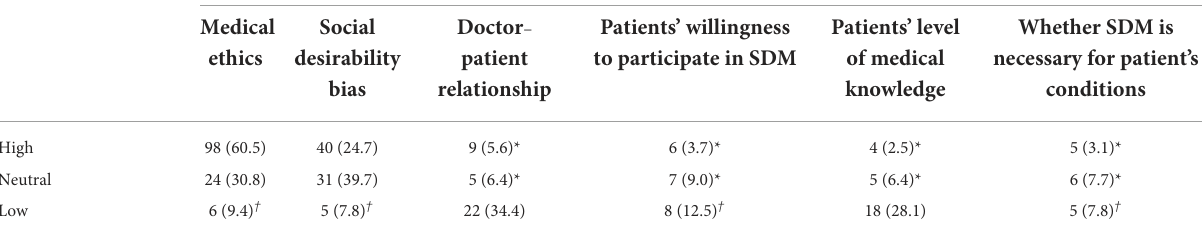
TABLE 6 Reasons for different preferences for shared decision-making (SDM) [ n (%)]. Level of propensity